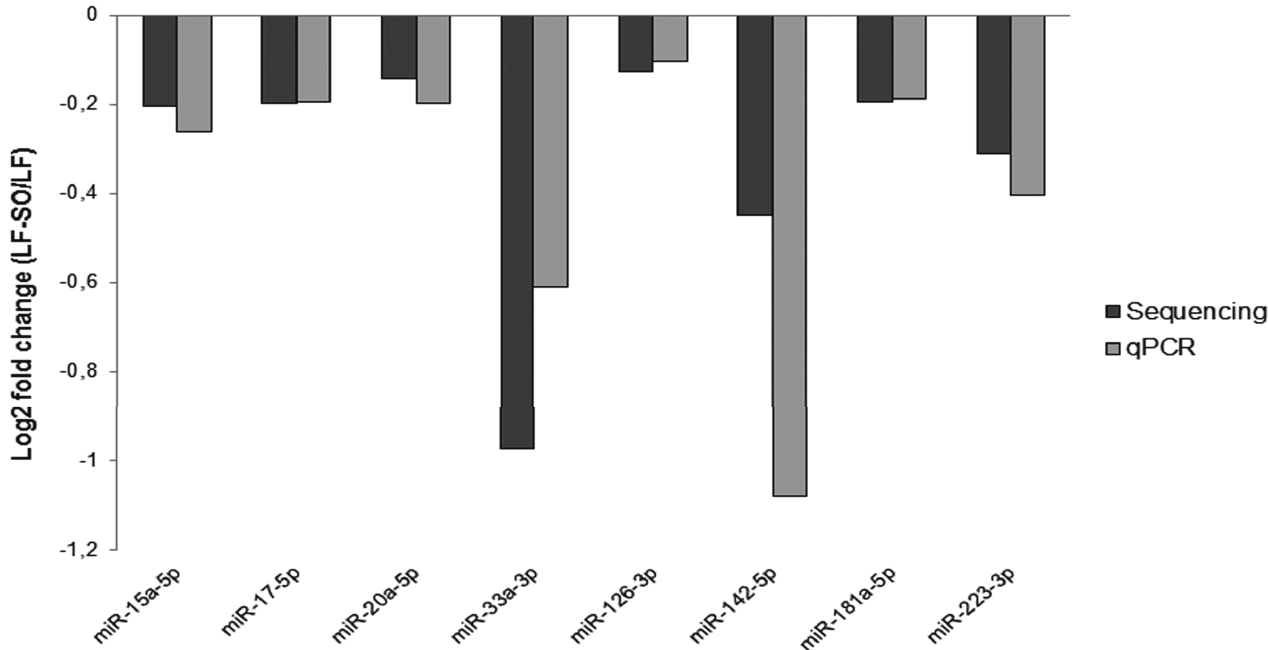
Fig 1. Comparison of the expressionof eight miRNA in mammarygland on 2 pools. The analyseswere performed on 2 RNA pools from 2 cows received a LF or LF-SO diet obtainedby qPCR and NGS approaches. Cows receiveda low forage diet (LF) or the same diet supplemented with 4% of sunfloweroil (LF-SO), n =